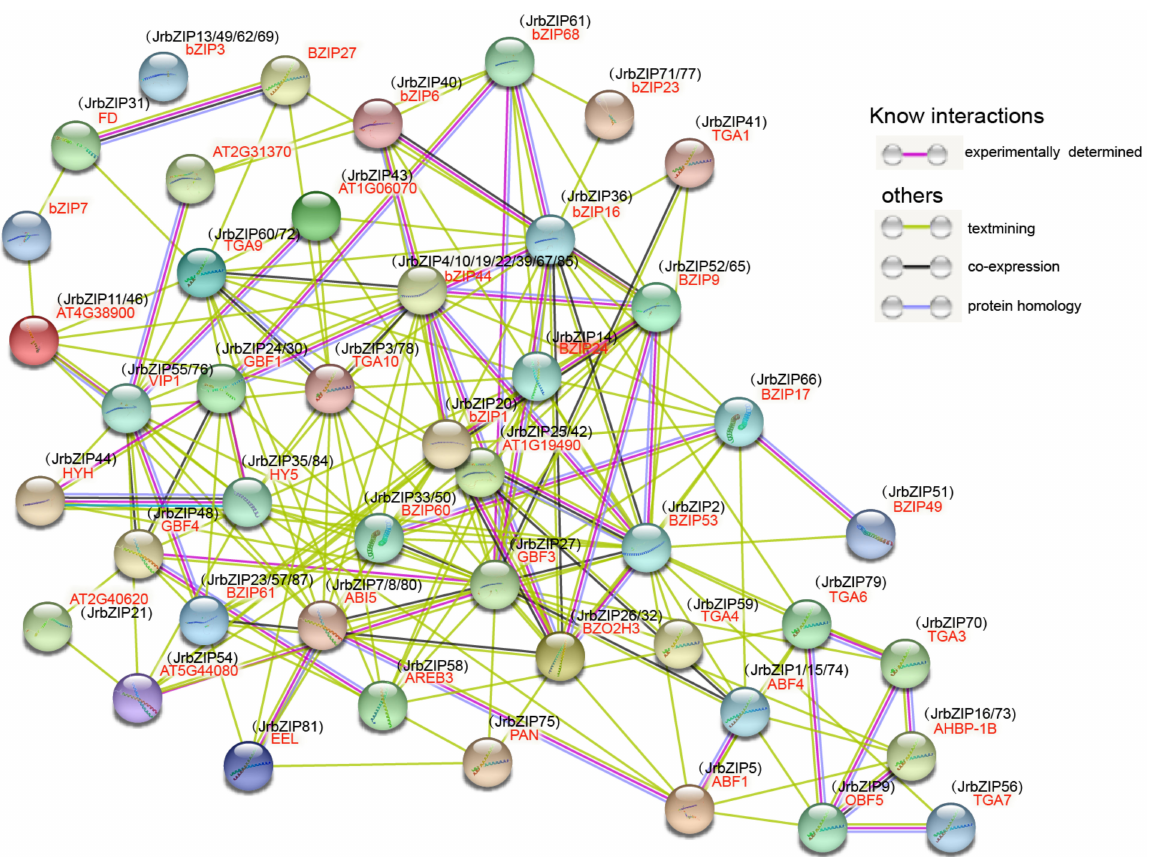
Figure 7. Predicted protein–protein interaction network of Jr bZIP protein. The network nodes represent proteins. The 3D structure of the protein is shown inside the nodes, and the line color indicates the type of interaction